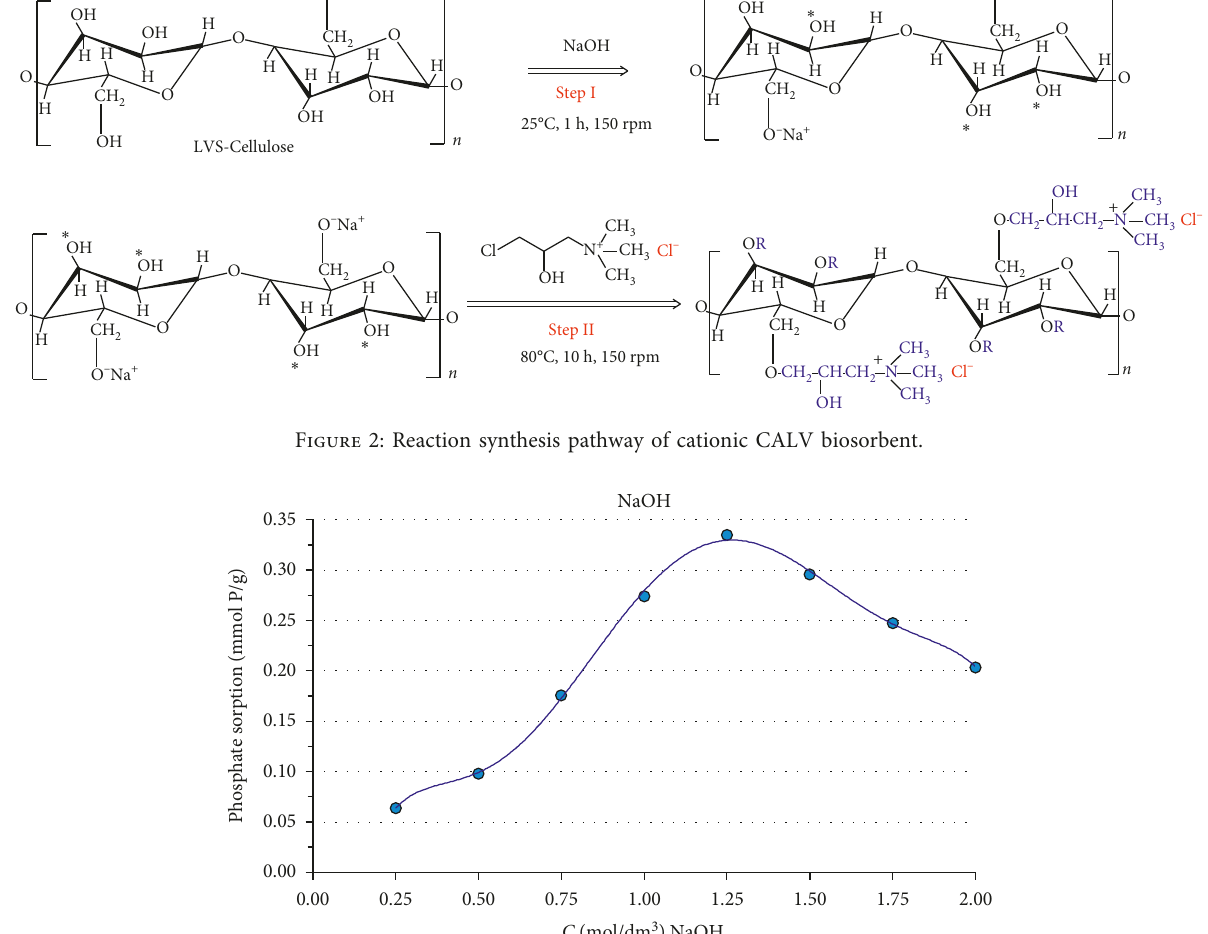
Figure 3: Phosphate sorption (expressed as P) by prepared CALV biosorbents in the function of different NaOH solution concentrations 3 (0.25–2.0mol dm · −